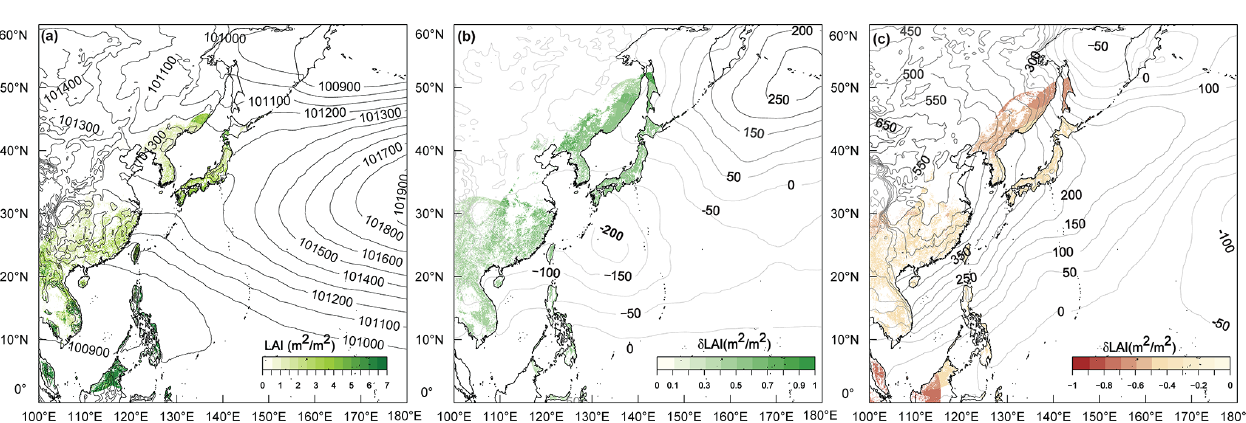
Figure 3. Pressure fields (Pa) and changes therein in the month of the passage of a tropical cyclone for cyclones that had a neutral, positive, or negative impact on the leaf area (m 2 m − 2 ) of forests. Effect sizes are based on the definition that uses 3 times the cyclone diameter and wind speed to identify the affected and reference areas (definition 3a in Table A1). (a) Mean atmospheric pressure and leaf area prior to the passage of a tropical cyclone that had a neutral impact on forest leaf area. (b) Changes in mean atmospheric pressure and leaf area between cyclones with a neutral and positive effect on leaf area. (c) Changes in mean atmospheric pressure and leaf area between cyclones with a neutral and negative effect on leaf